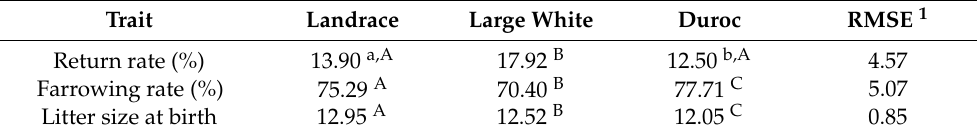
Table 1. Phenotypic differences between breeds.